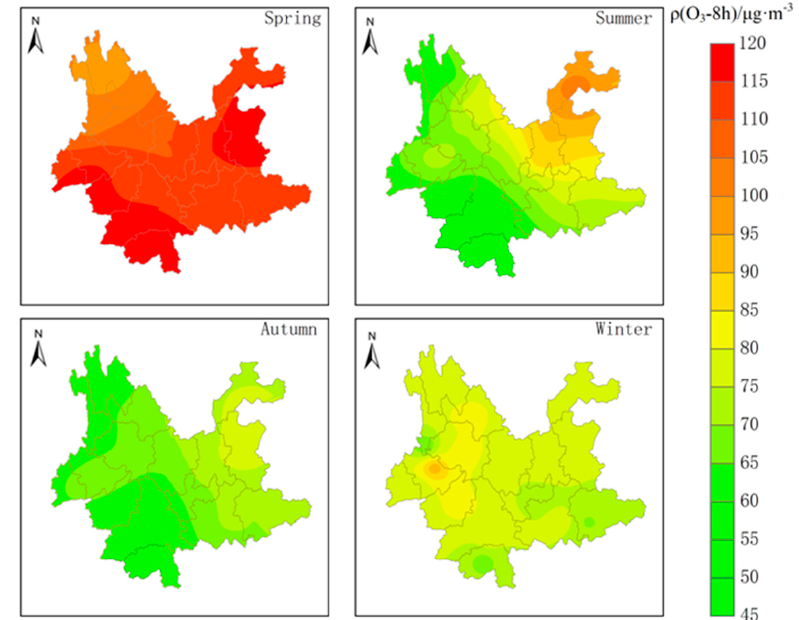
Figure 6. Average distribution of O 3 -8h concentration in four seasons in Yunnan from 2015 to 2020.